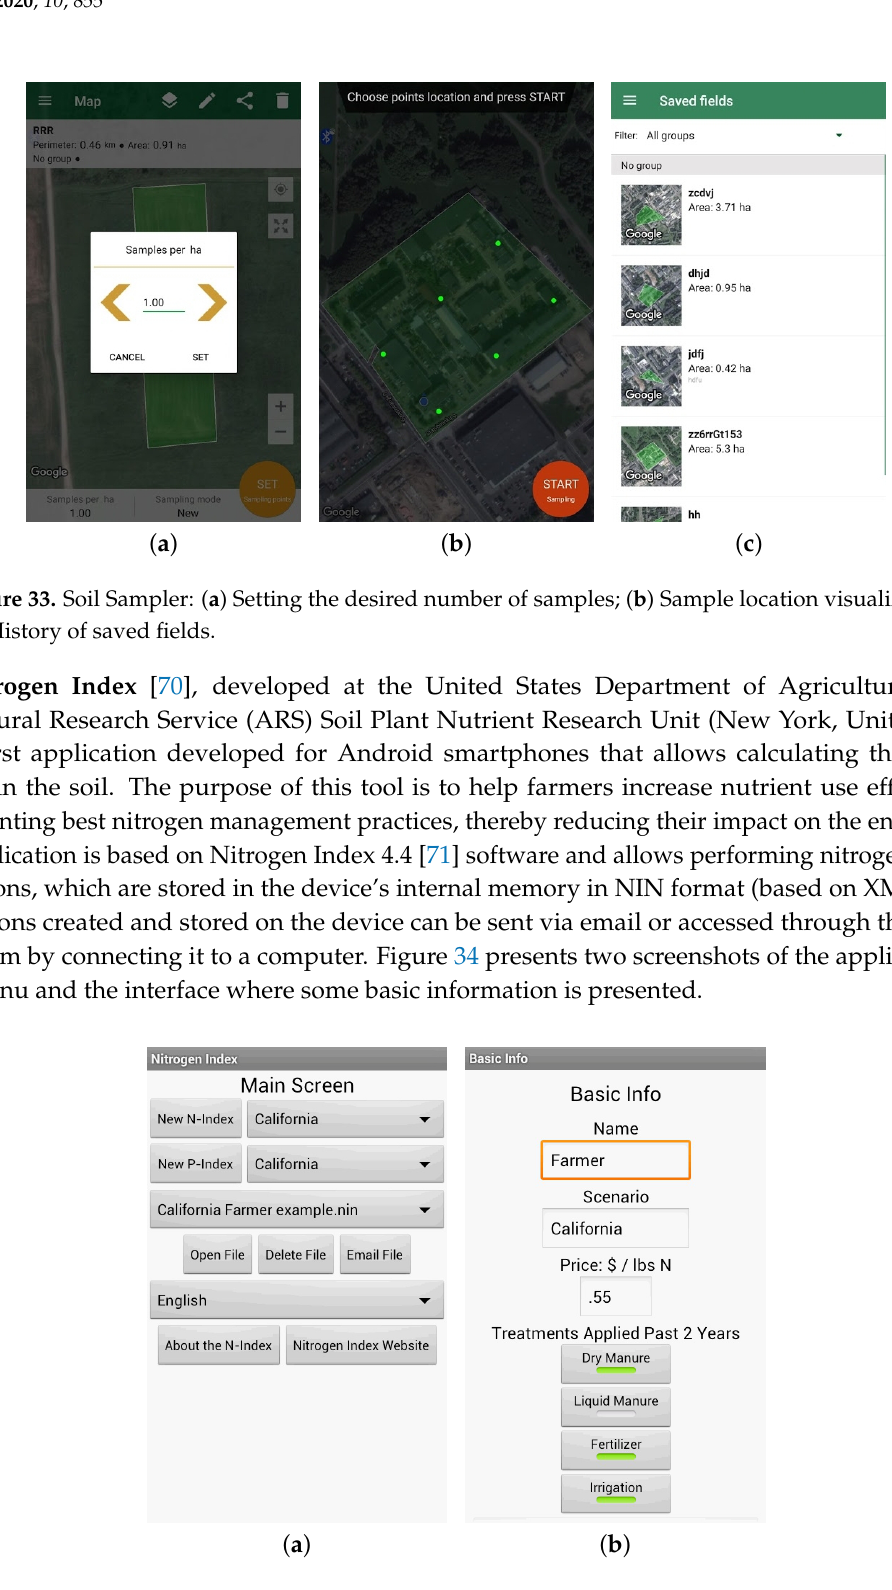
Figure 34. Nitrogen Index: ( a ) Main menu; ( b ) Basic info